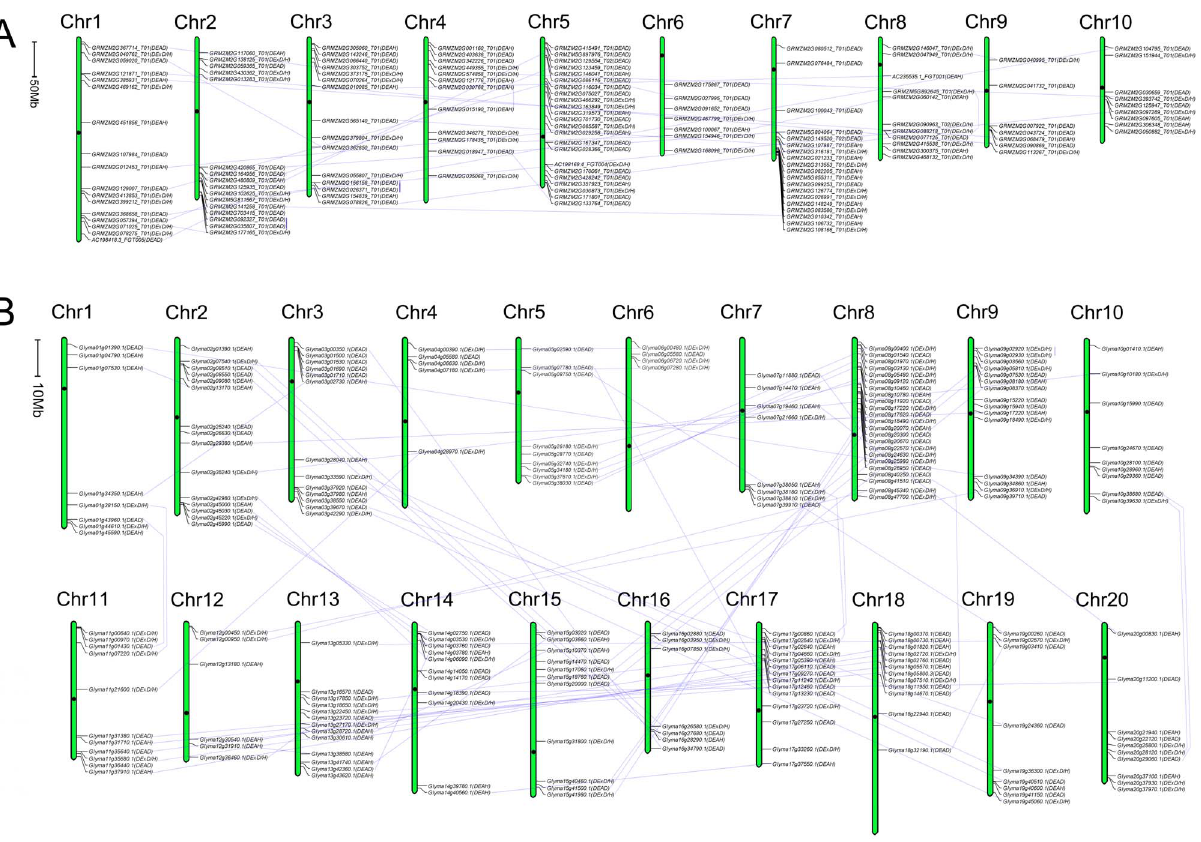
Figure 2. The chromosomal mapping of the RNA helicase gene family. (A) Zea mays , (B) Glycine max . The scale bar represents a 10.0 Mb chromosomal distance. The chromosome number is indicated at the top of each chromosome. To simplify the presentation, we named the putative RNA helicase genes with their own Gene ID. The subfamily of each RNA helicase gene was shown in parentheses. The paralogous sister pairs of RNA helicase genes were connected by light blue line, which had very strong bootstrap support ( . 90%). The positions of centromeres were marked with the black dot.